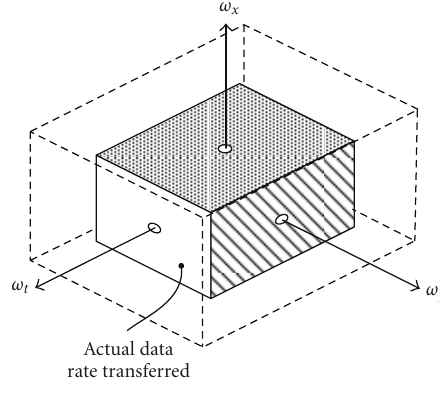
Figure 3: Digital camcorder actual capacity.